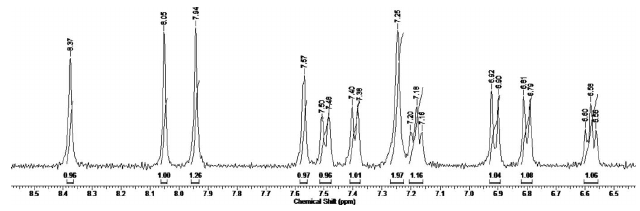
Figure 4 400 MHz 1 H NMR spectrum of (I) in DMSO- d 6 at 293 K in the range 8.5– 6.5